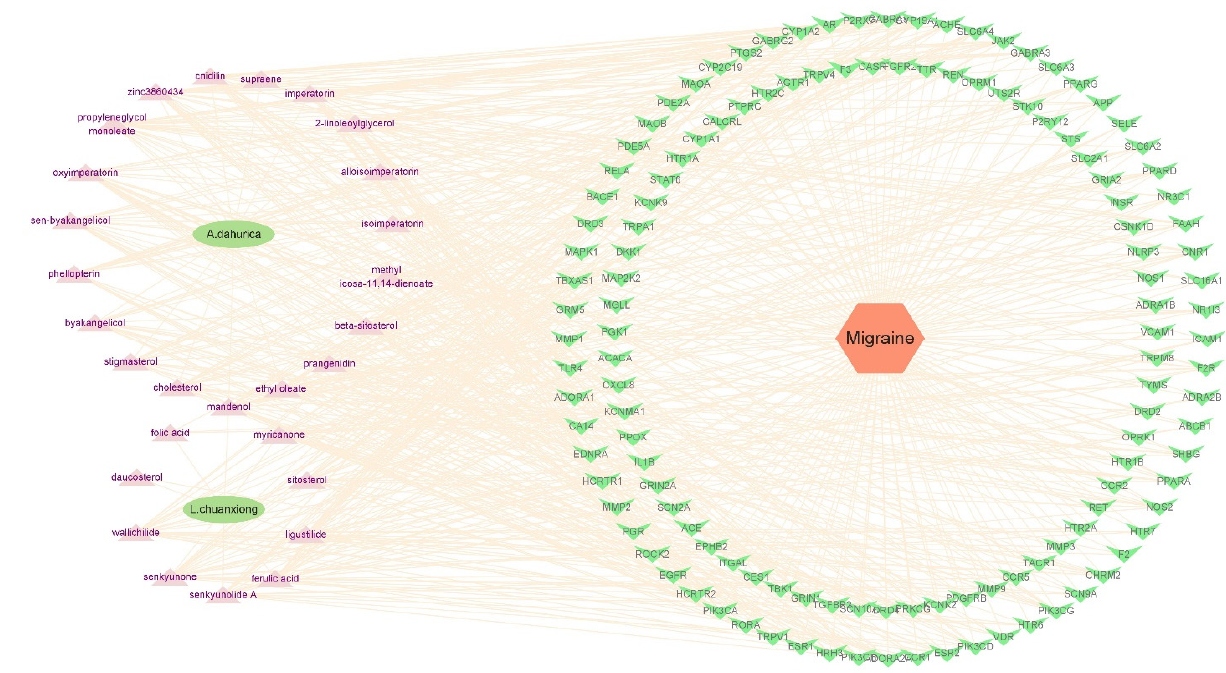
Figure 2. The herb–compound–target–disease network associated with ALHP and migraines.